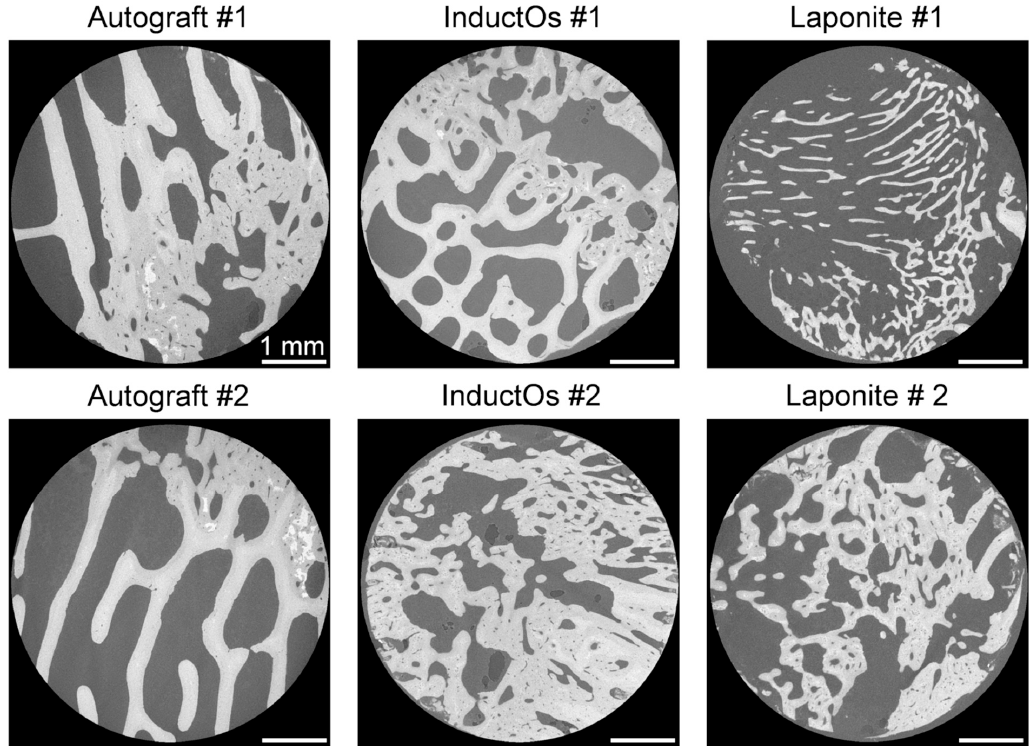
Figure 3. MicroCT cross-sections through the six analyzed specimens, showing differences in microstructure and mineralization. Large agglomerates of mineral (white) were identified in Autograft specimens. Laponite #1 showed considerably thinner trabeculae. Large areas of woven bone were present in InductOs and Laponite #2 specimens. Scale bars = 1 mm.